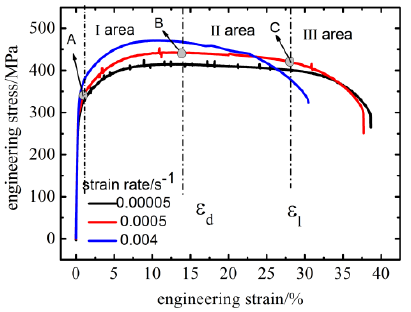
Figure 2. Engineering stress–strain curves of as-received CP-Ti.